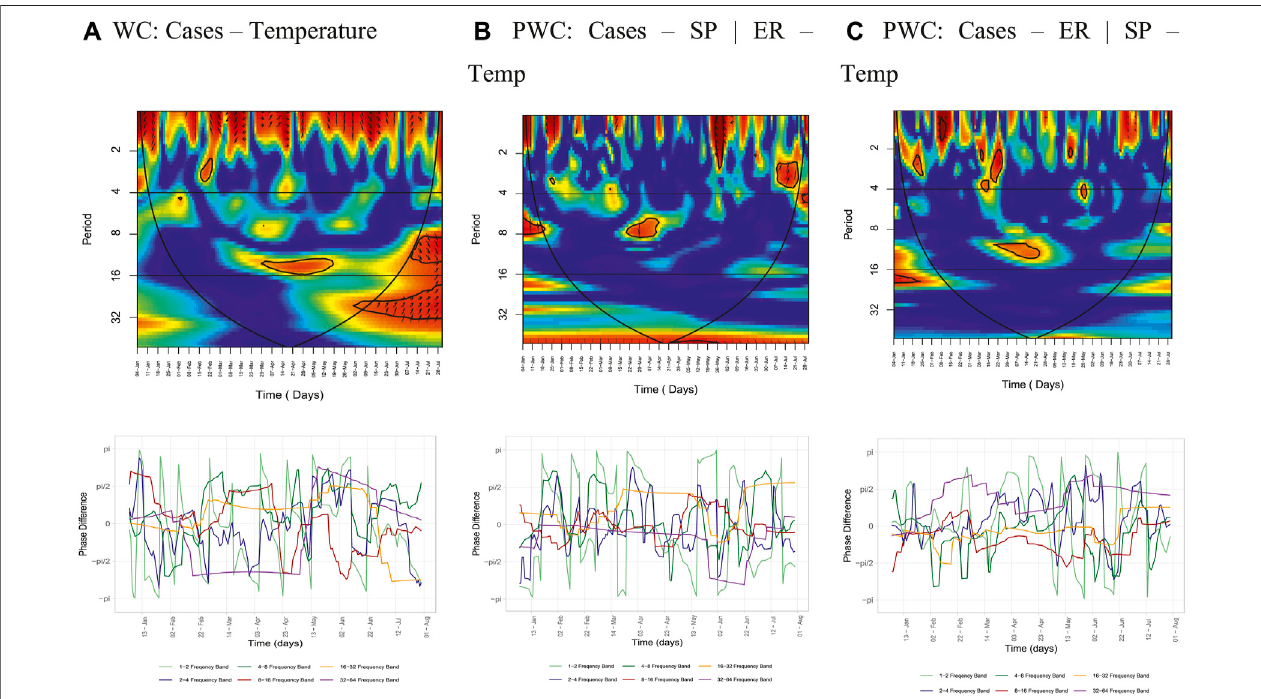
FIGURE 4 | France. (A) WC: Cases — Temperature. (B) PWC: Cases — SP | ER — Temp. (C) PWC: Cases — ER | SP —